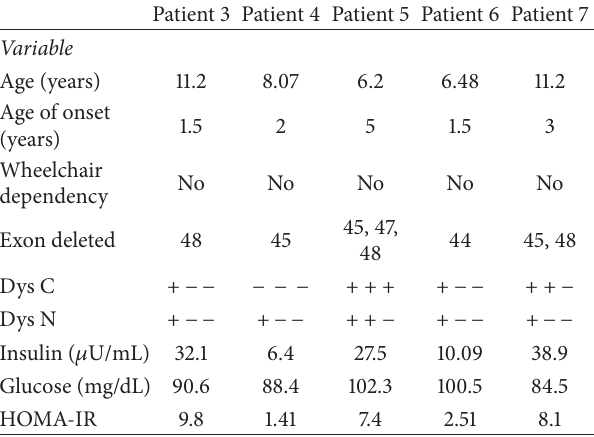
Table 3: Characteristics of patients and cellular localization of molecules involved in glucose